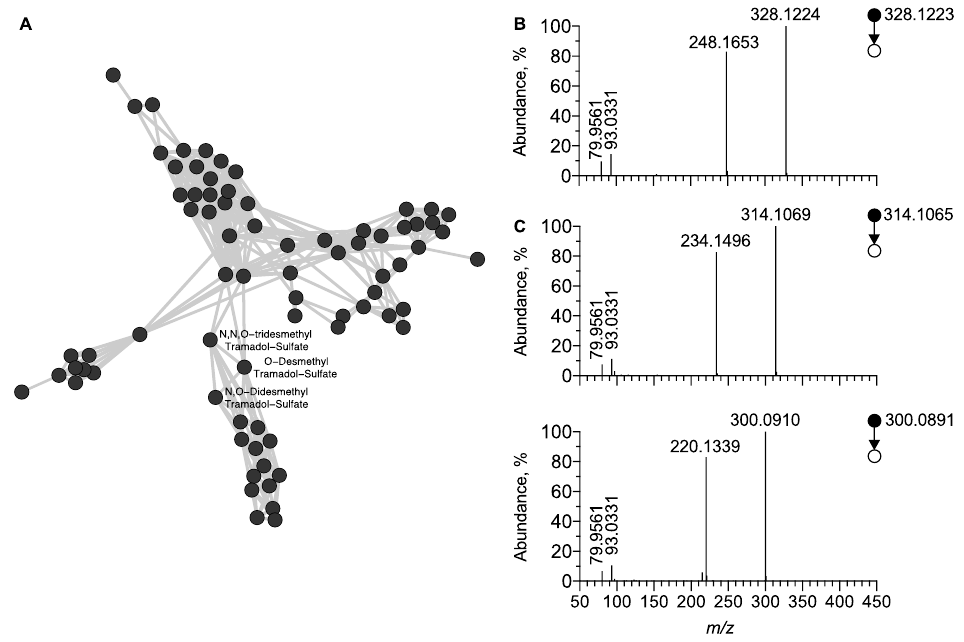
Figure 7. Molecular network of sulfo-conjugated molecules generated under negative ion mode.